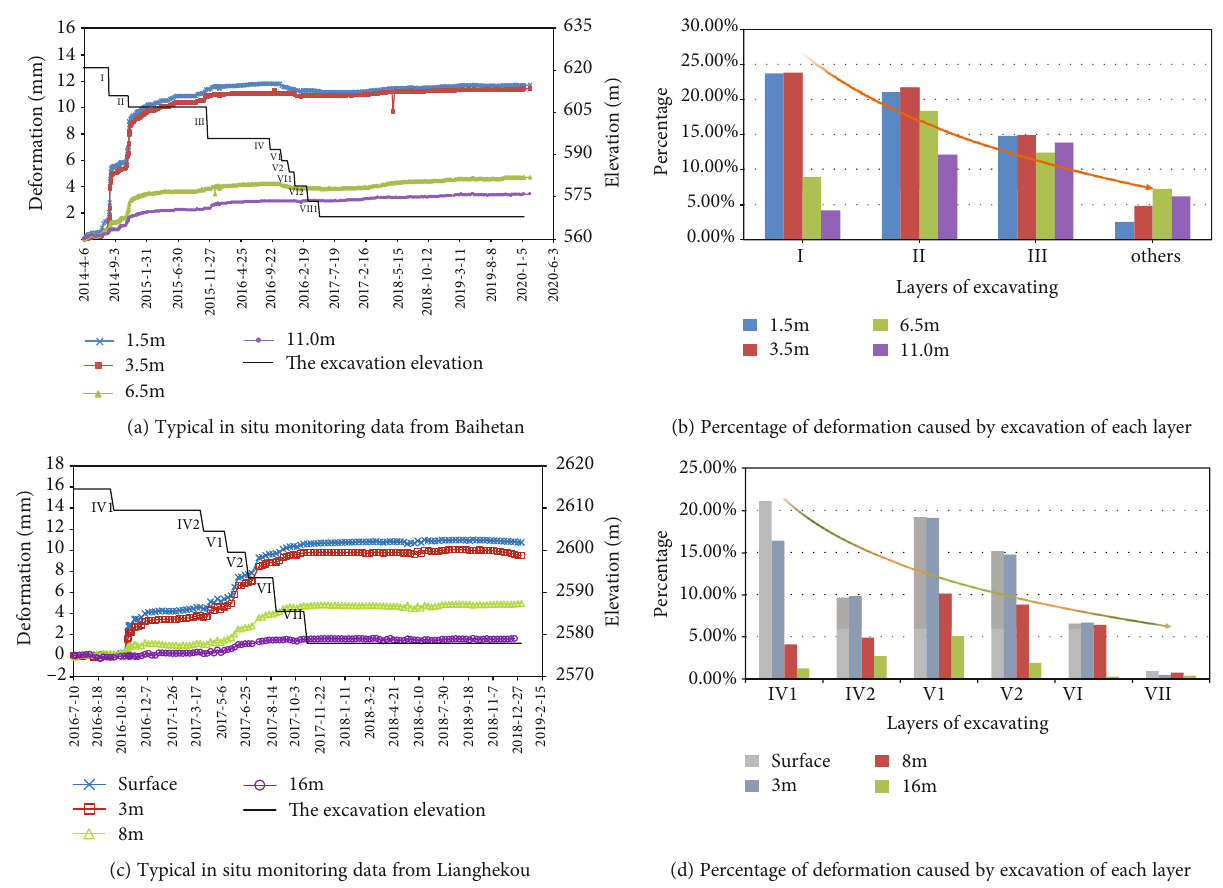
Figure 3: Time-displacement curves for typical surrounding rock deformation measuring points.